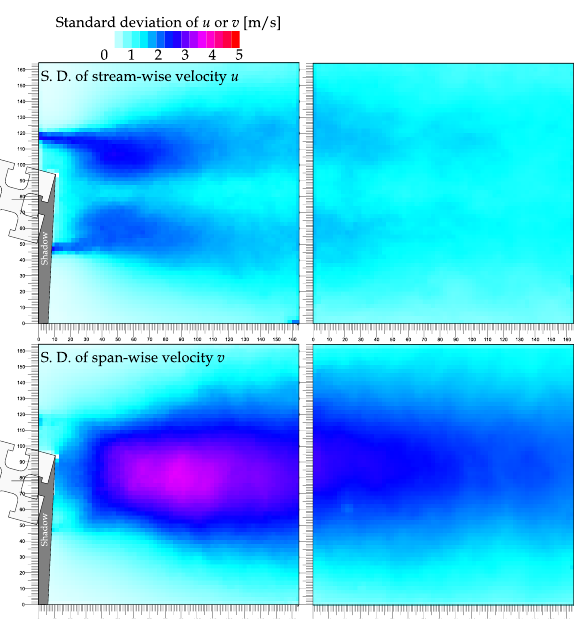
Fig. 5. Comparison of the standard deviations of stream-wise velocity u ( top ) and span-wise velocity v ( bottom ). Here are displayed only data at angle α = 15 ◦ , other data have similar ratio of these two components.